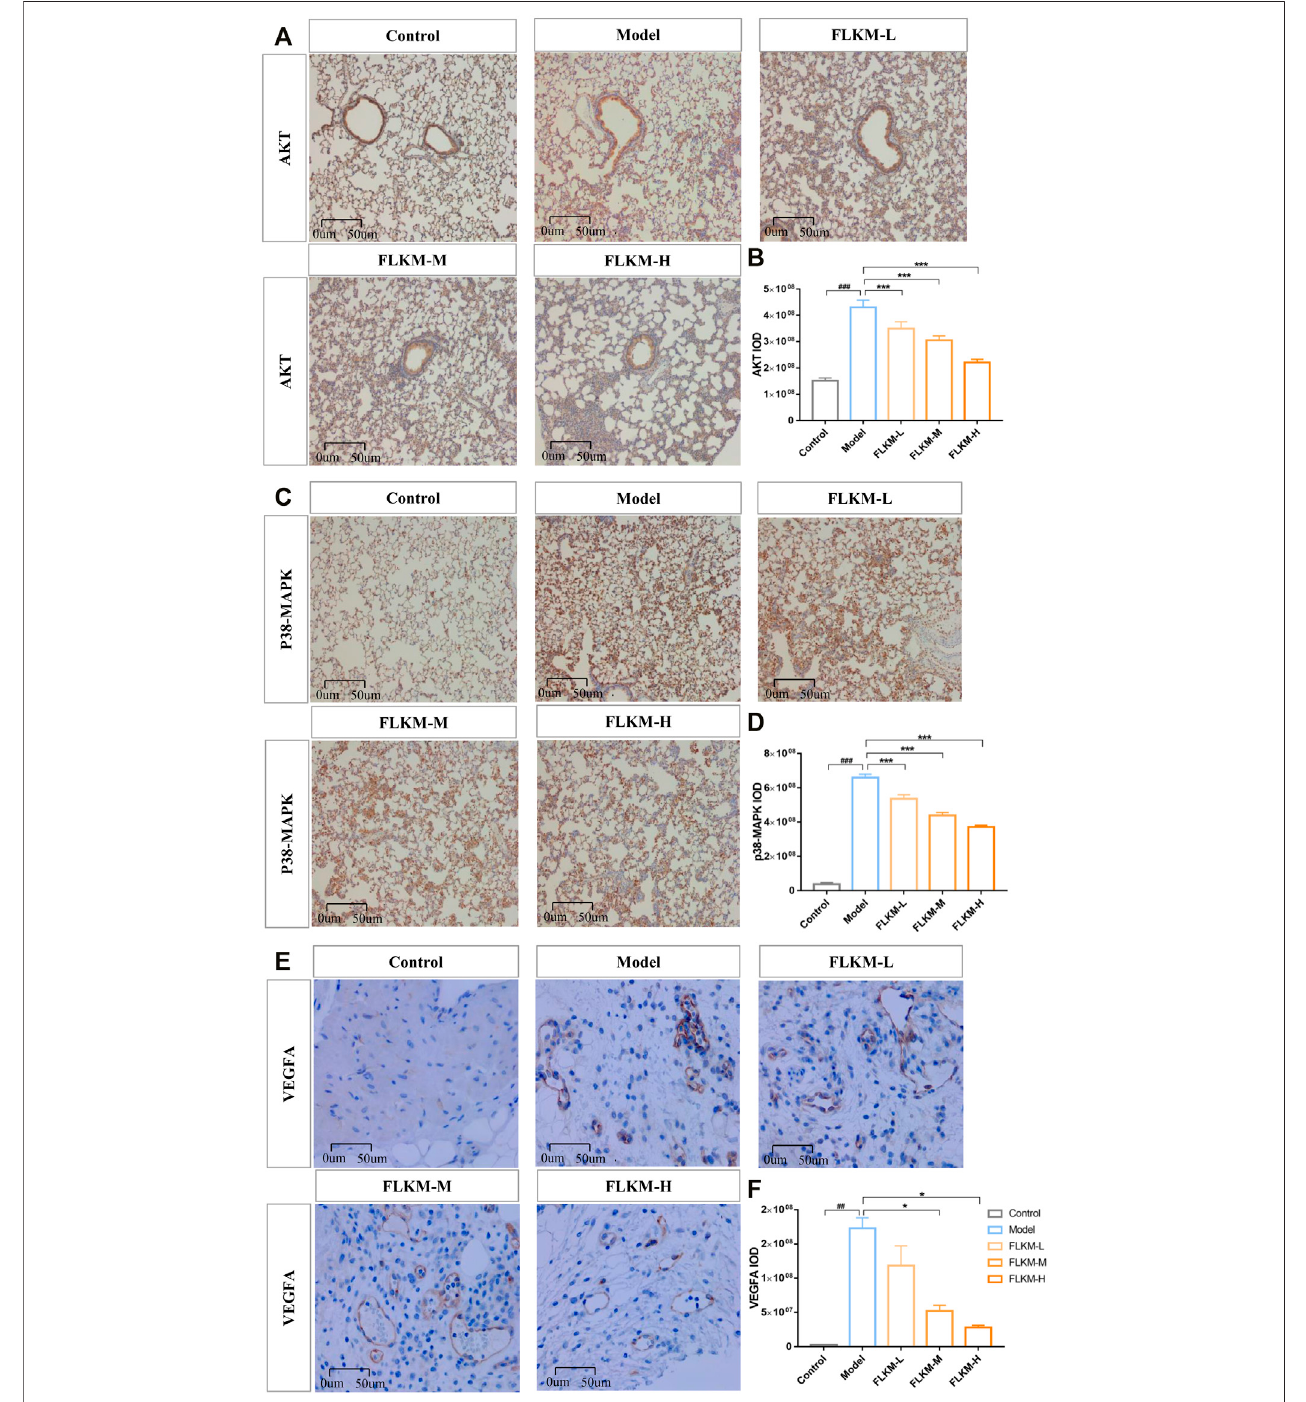
FIGURE5| ExperimentalassessmentoftheFLKMactionontargetspredictedbynetworkpharmacology. (A,C,E) areimmunohistochemistrymicrographsofAKT, VEGFA, and p38-MAPK in fi ve groups, respectively. Scale bar = 50 µm. (B,D,F) are quantitative determination the expression of AKT, VEGFA and p38-MAPK using integrated optical density (IOD); IOD = average optical density × positive area. The data are expressed asthe mean ± SD ( n = 3). # p < 0.05, ## p < 0.01 and ## p < 0.001 compared with the control group; * p < 0.05, ** p < 0.001 and *** p < 0.01 compared with the model group.